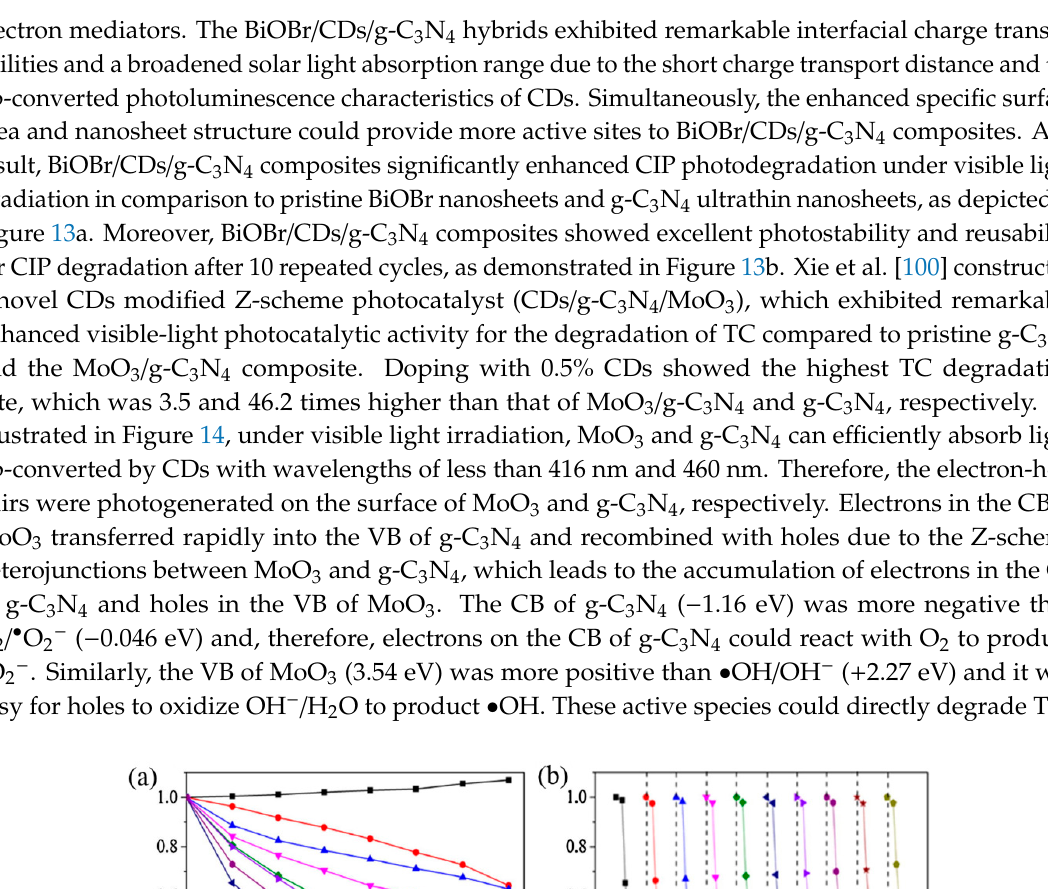
Figure 14. Proposed photocatalytic degradation mechanisms of TC under visible light irradiation with 0.5CCM3 composites (reproduced with permission from [100]. Copyright Elsevier, 2018).